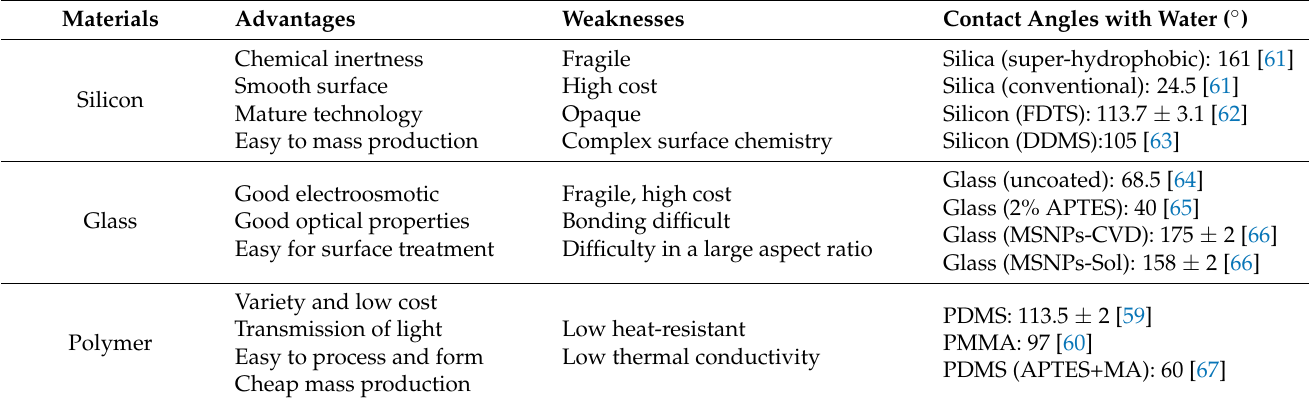
Table 1. Properties of different materials for preparing microfluidic